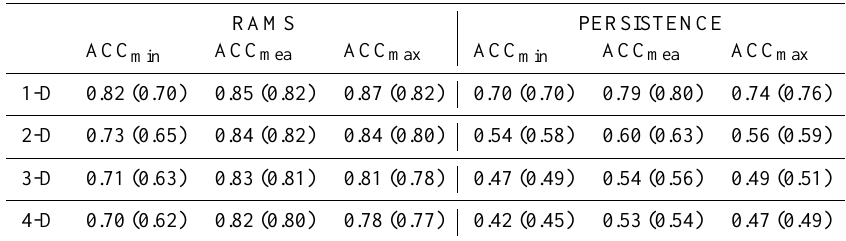
Table 3. Average of the ACC for the whole period for RAMS and persistence forecasts. The seasonal average is computed as the average of the OI analyses for the period considered. Persistence is computed from OI analyses. ACC min columns are for minimum temperature, ACC mea columns are for mean temperature, and ACC max columns are for maximum temperature. Values into parentheses show the ACC statistic computed using SI seasonal average and the persistence computed from SI